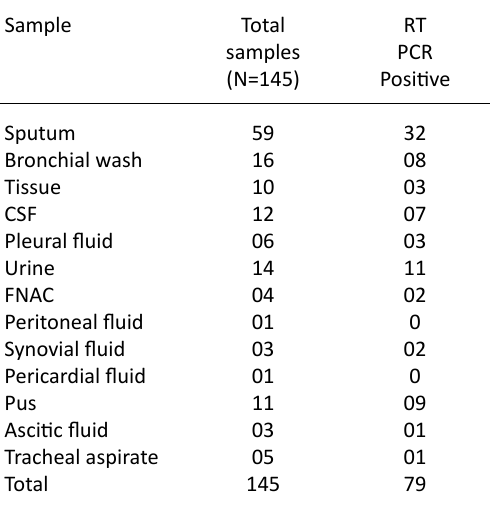
Table 1. Distribution of samples from pulmonary and extra pulmonary tb and the RT PCR test outcome Sample